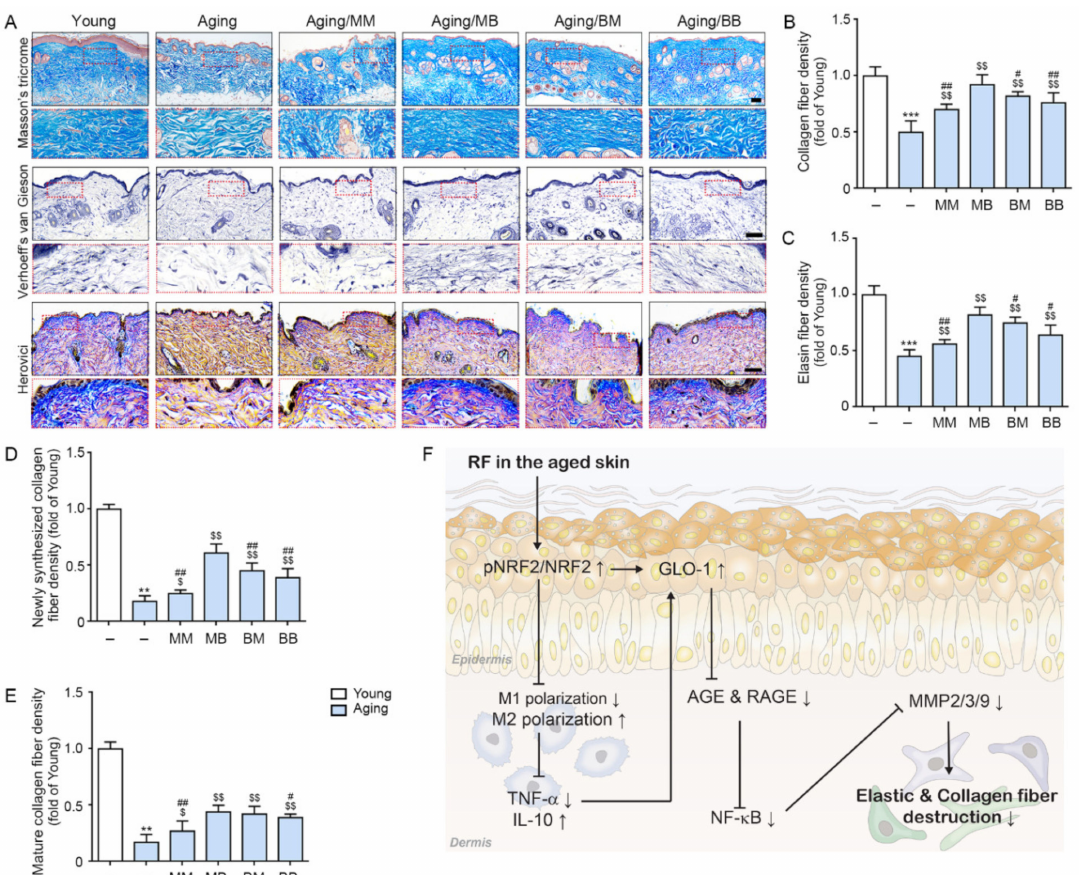
Figure 5. The recovery effect of the collagen and elastin fibers depending on the combinations of RF modes: ( A ) Masson’s trichrome stain (first lane) demonstrated the collagen fibers, Verhoeff’s van Gieson stain (second lane) identified the elastin fibers, and Herovici collagen stain (third lane) demonstrated the amount of young collagen fibers in the dermis of the aged mice skin (scale bar = 100 µ m). ( B – E ) Quantitative graph representing ( B ) Masson’s trichrome stain, ( C ) Verhoeff’s van Gieson stain images, and ( D , E ) Herovici collagen stain images. ( F ) The summary of this study. Data are presented as mean ± SD. **, p < 0.01 and ***, p < 0.001, vs. Young; $, p < 0.05 and $$, p < 0.01, vs. Aging; #, p < 0.05 ##, p < 0.01, vs. Aging/MB (Mann–Whitney U test). MM, monopolar mode applied twice; MB, application of monopolar mode followed by bipolar mode; BB, bipolar mode applied twice; BM, application of bipolar mode followed by monopolar